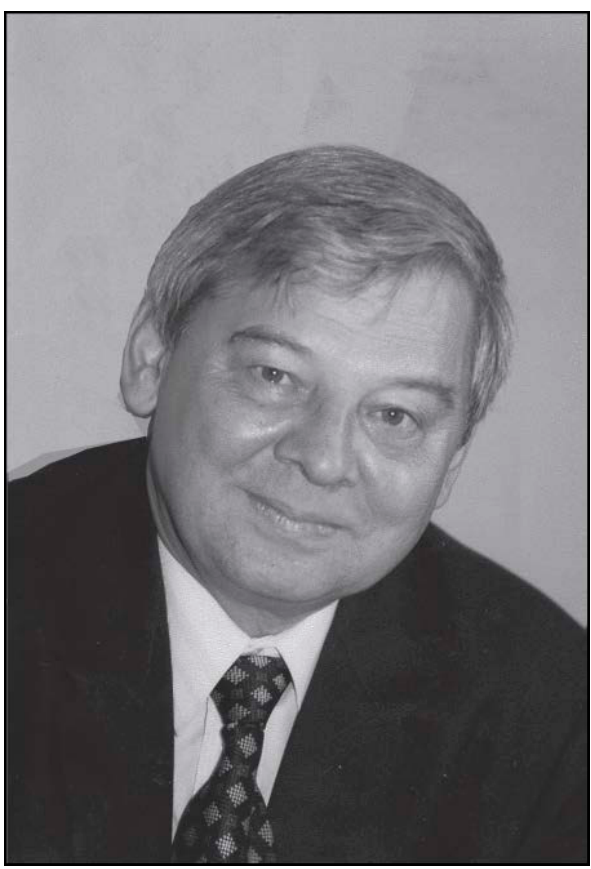
Figure 4. Yuri Alexandrovich Ustynyuk. from an article in the “Bul- letin of Moscow State University” (2017).